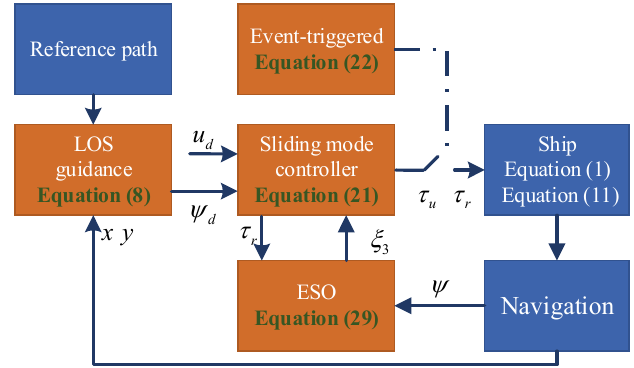
Figure 1. Technical framework for event ‐ triggered ‐ based sliding mode controller.